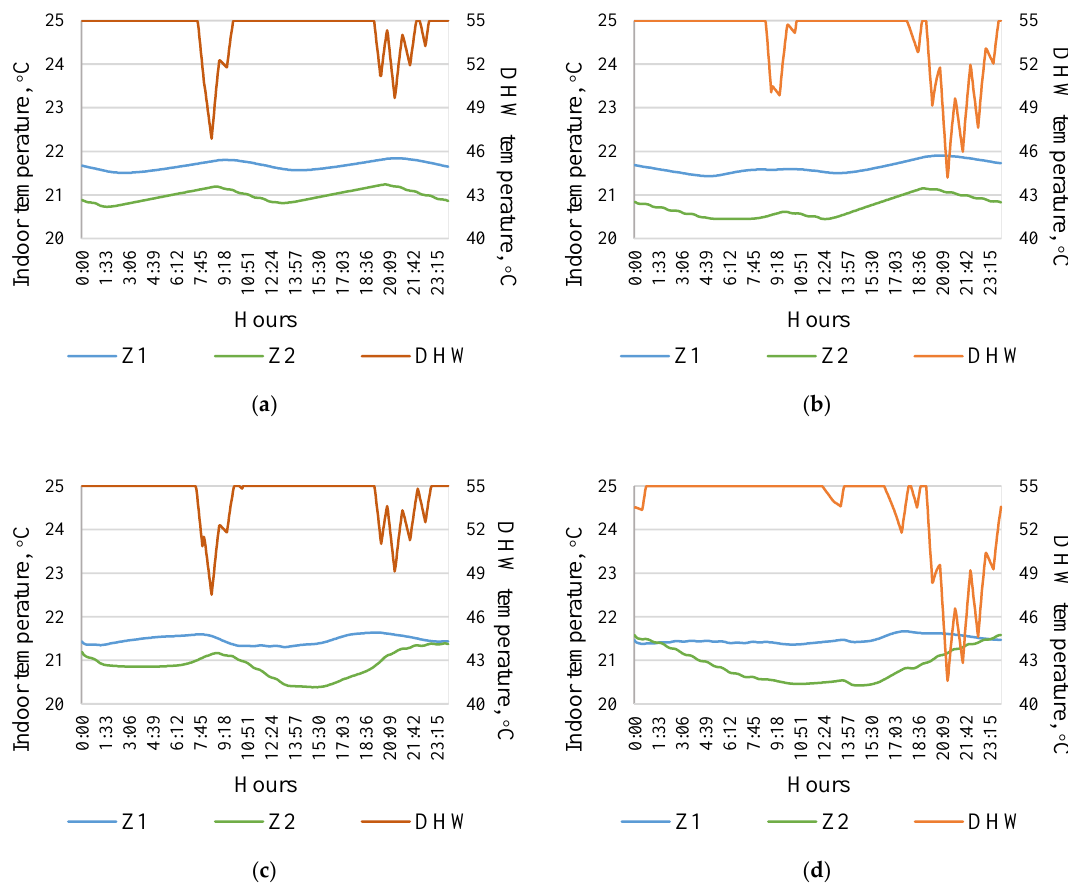
( b ) Figure 14. Effect of heating mode duration on ( a ) indoor temperature and ( b ) DHW outlet